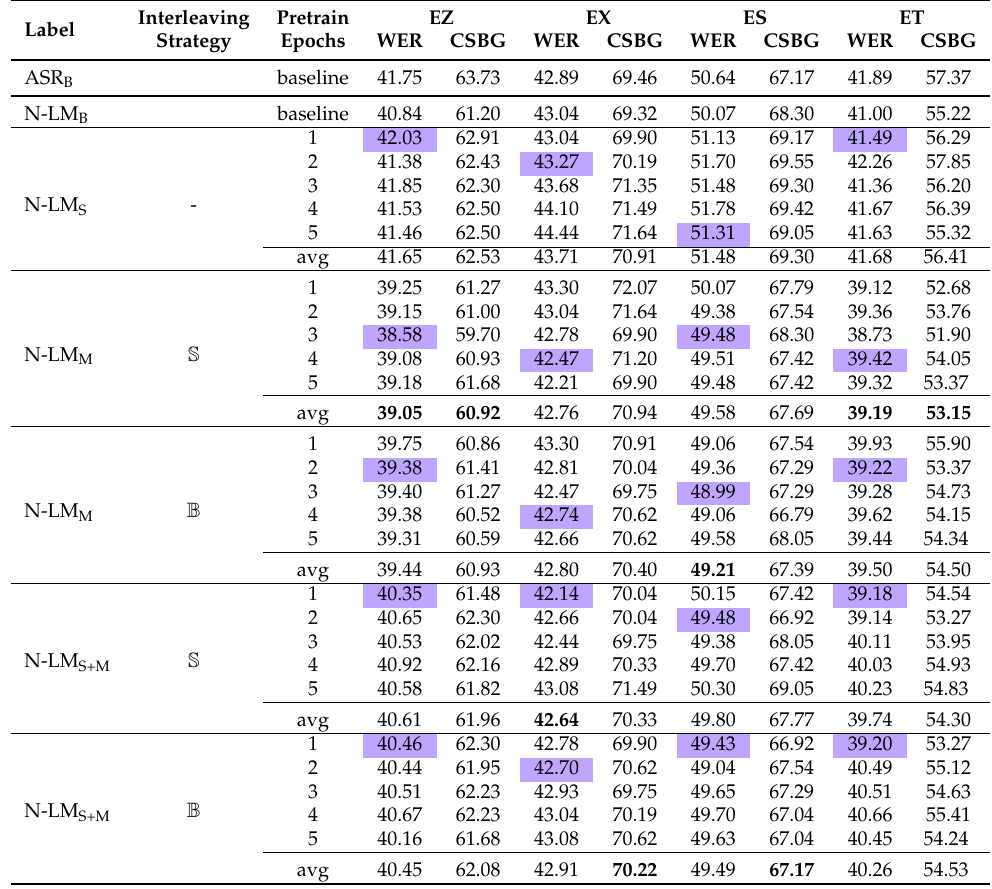
Table 6. Test set word error rates (WER) and code-switched bigram error rates (CSBG) during the optimisation of the pretraining strategy for each of the respective language pairs: English–isiZulu (EZ), English–isiXhosa (EX), English–Sesotho (ES), and English–Setswana (ET). The epochs that afforded the lowest development set word error rate are highlighted. The best average performance over the five pretraining epochs across the different strategies on the test set is denoted in